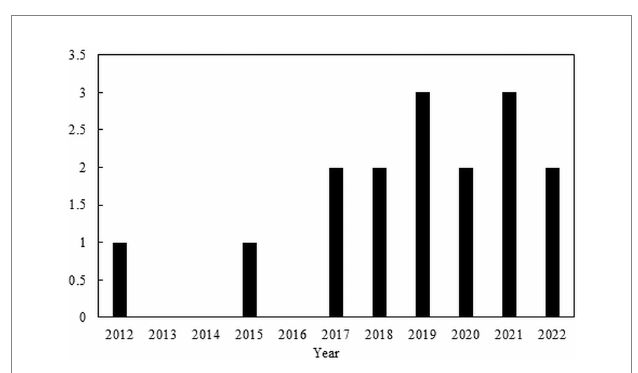
FIGURE 3 Trends articles of CAP for inactivation of ARBs and ARGs in water